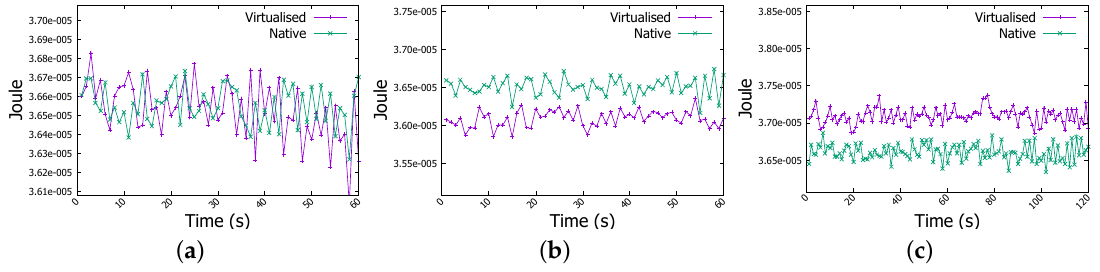
Figure 13. Energy measurement in WordCount job. ( a ) 1 GB file; ( b ) 4 GB file; ( c ) 6 GB file.